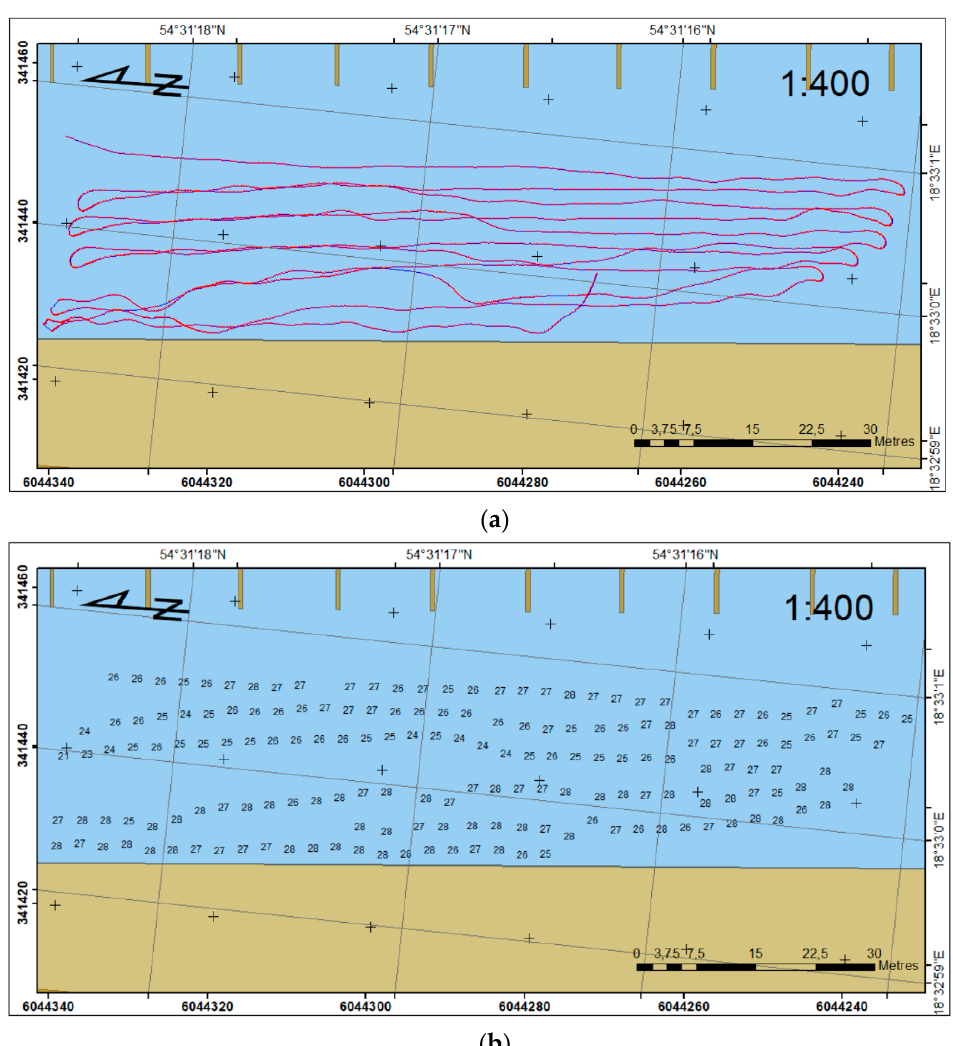
Figure 8. USV trajectory ( a ), total number of used satellites ( b ) for USV positioning (GPS + GLONASS + Beidou+ Galileo).